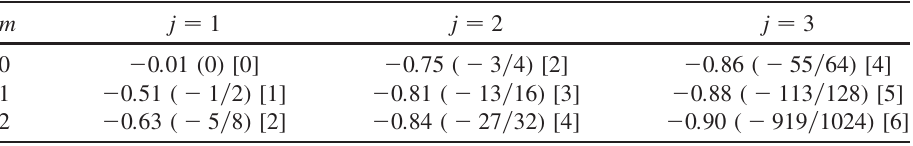
TABLE I. Eigenvalues of the boxcar